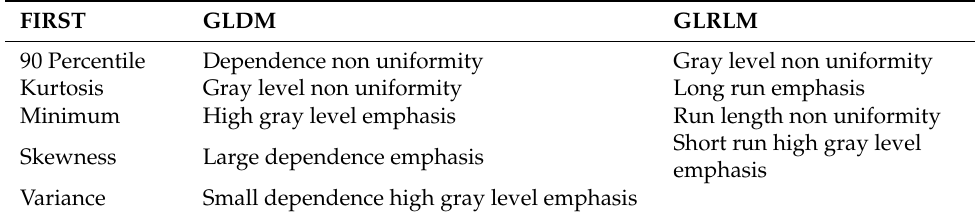
Table 2. Radiomic feature set for the second tier (or step 2).